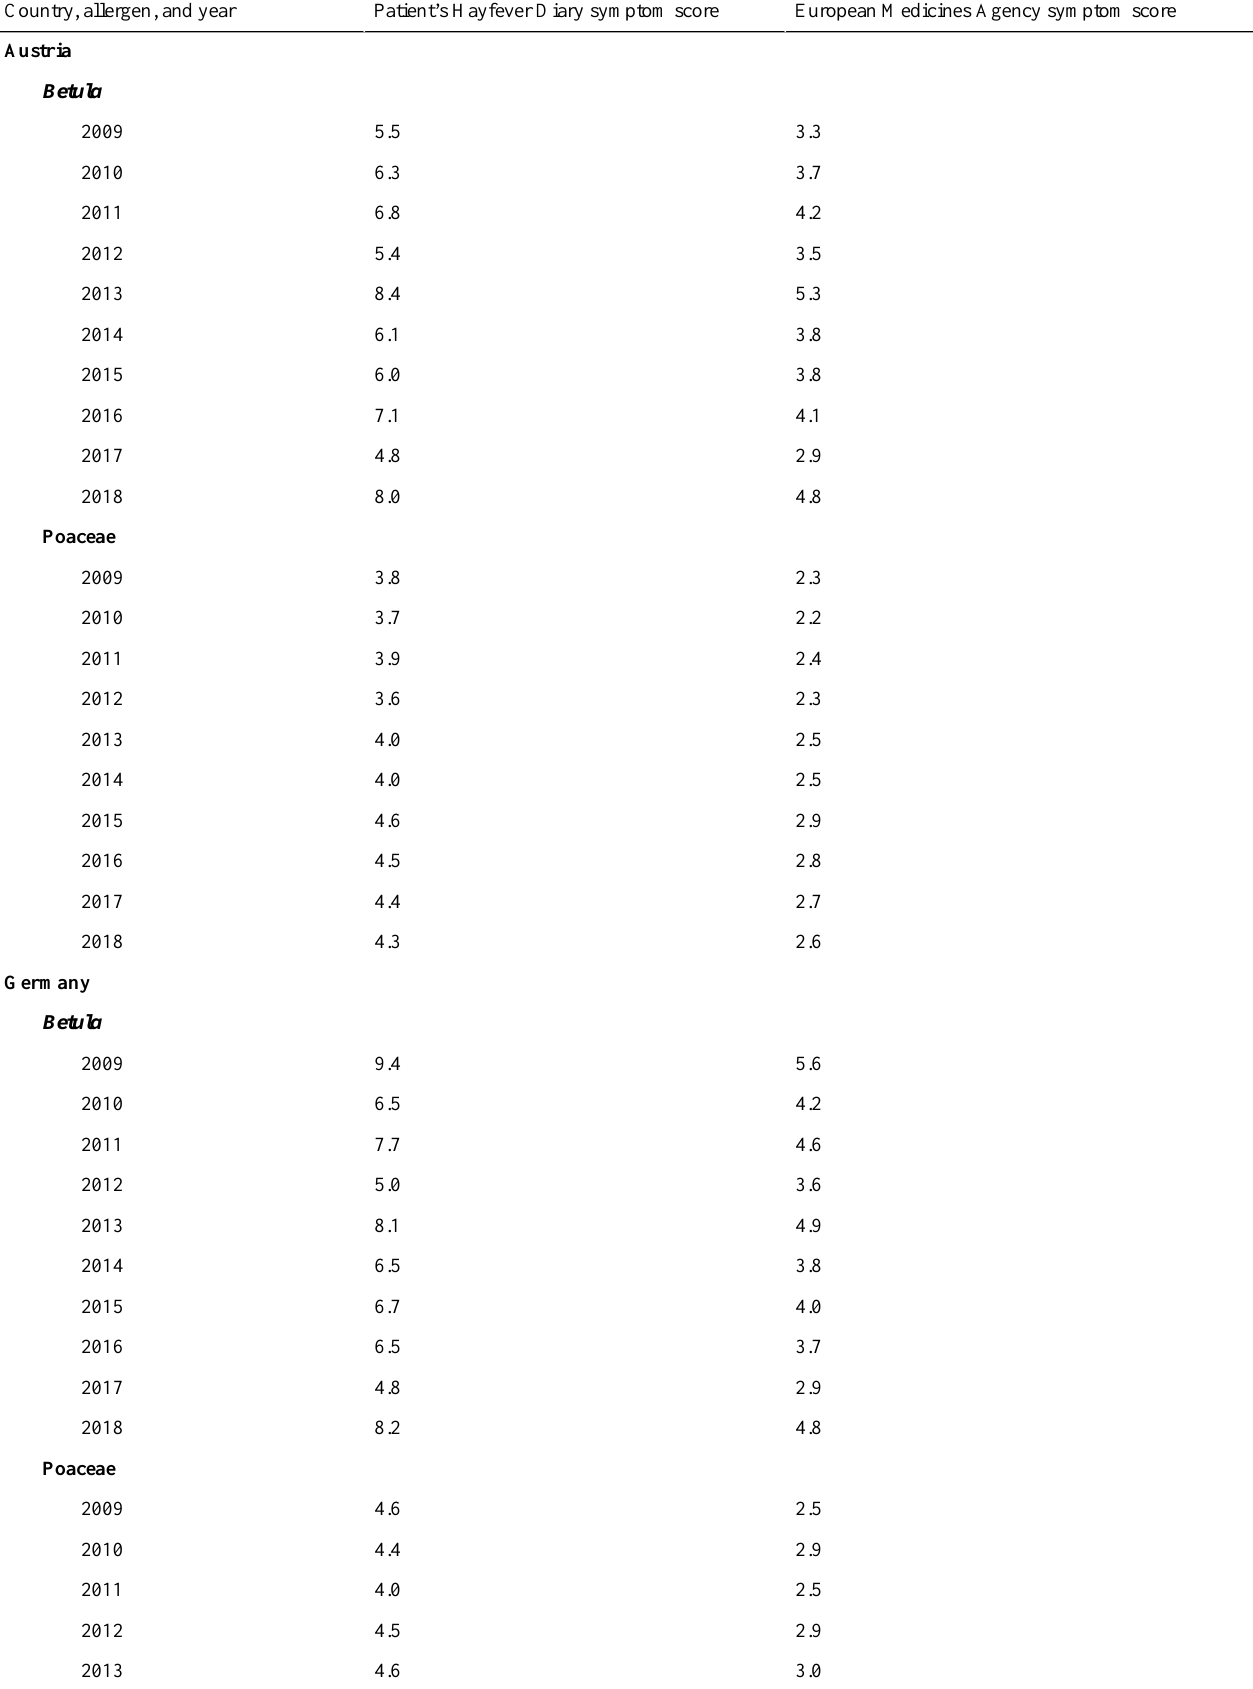
Table 1. Results of the calculation of the raw Patient’s Hayfever Diary symptom score and the raw European Medicines Agency symptom score per year, season, and